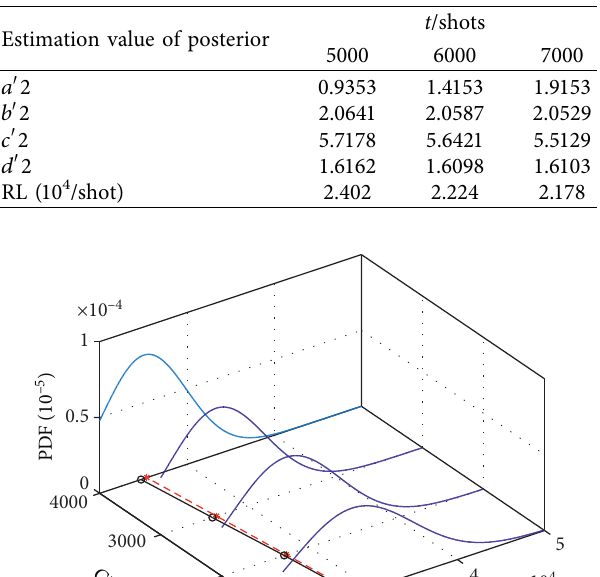
Table 4: Updated hyperparameters based on the Bayesian method (2nd stage).